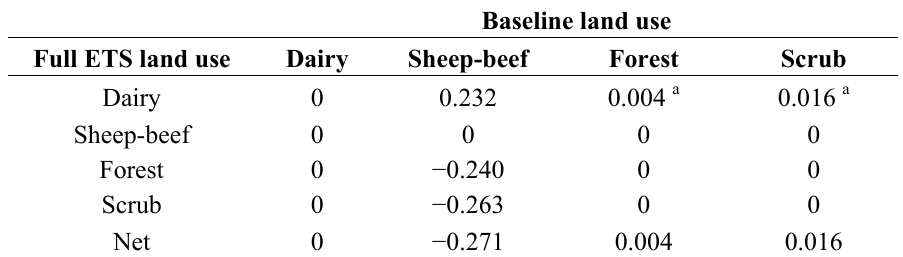
Table 4. Differences in agricultural emissions (in gigagrams of CO decomposed by 2030 land